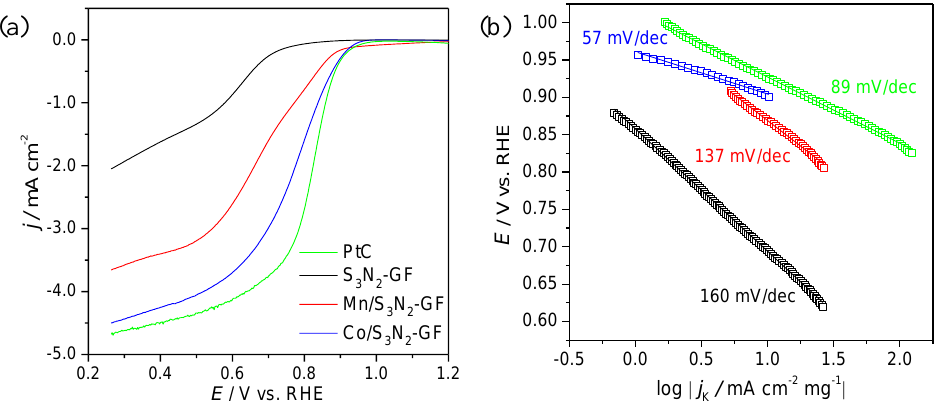
Figure 6. ORR LSV curves obtained in 0.1 mol dm -3 KOH saturated with O 2 for Pt/C, S 3 N 2 –GF, Co/S 3 N 2 –GF and Mn/S 3 N 2 –GF at 1600 rpm and 0.005 V s -1 ( a ) and the corresponding ORR Tafel plots ( b ).